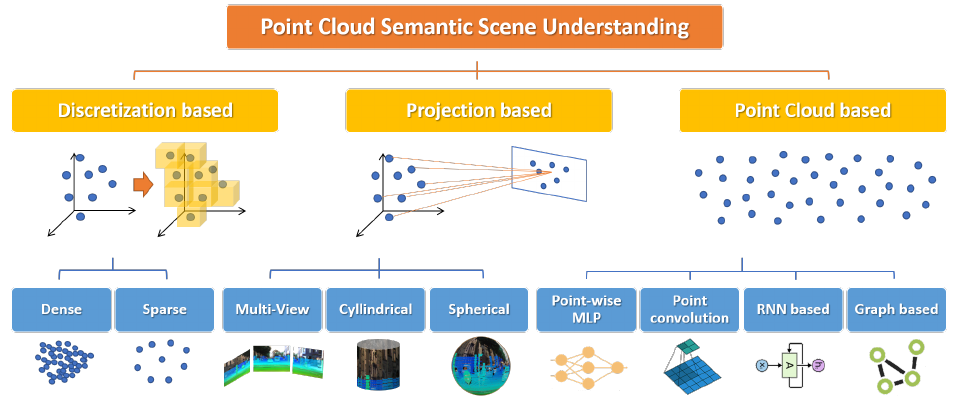
Figure 5. Taxonomy of the main methods for PC Semantic Scene